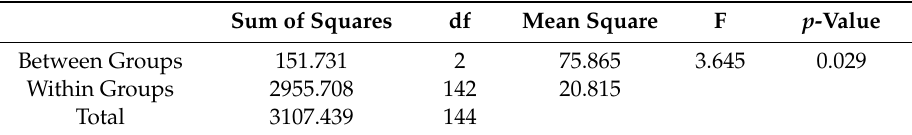
Table 7. ANOVA PET analyses in the three investigated selected